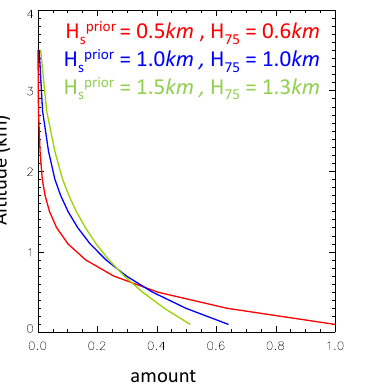
Figure 2. Method A is run with three different a priori profile shapes (see Eq. 2), each with a different characteristic profile height ( H 75 ).